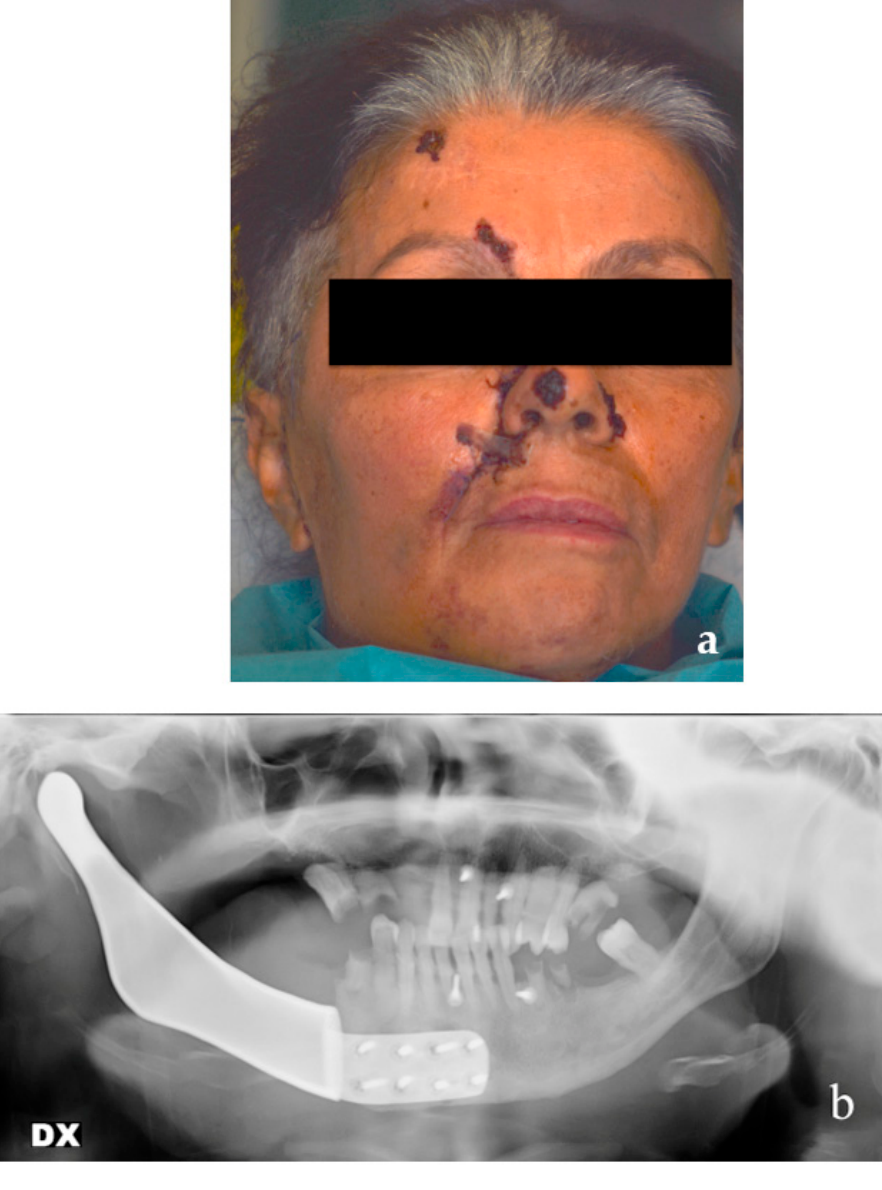
Figure 8. ( a ) Post-surgical frontal clinical view of the restored symmetry of the lower third of the face. ( b ) Post-surgery panoramic X-ray of the mandibular prosthesis positioning.